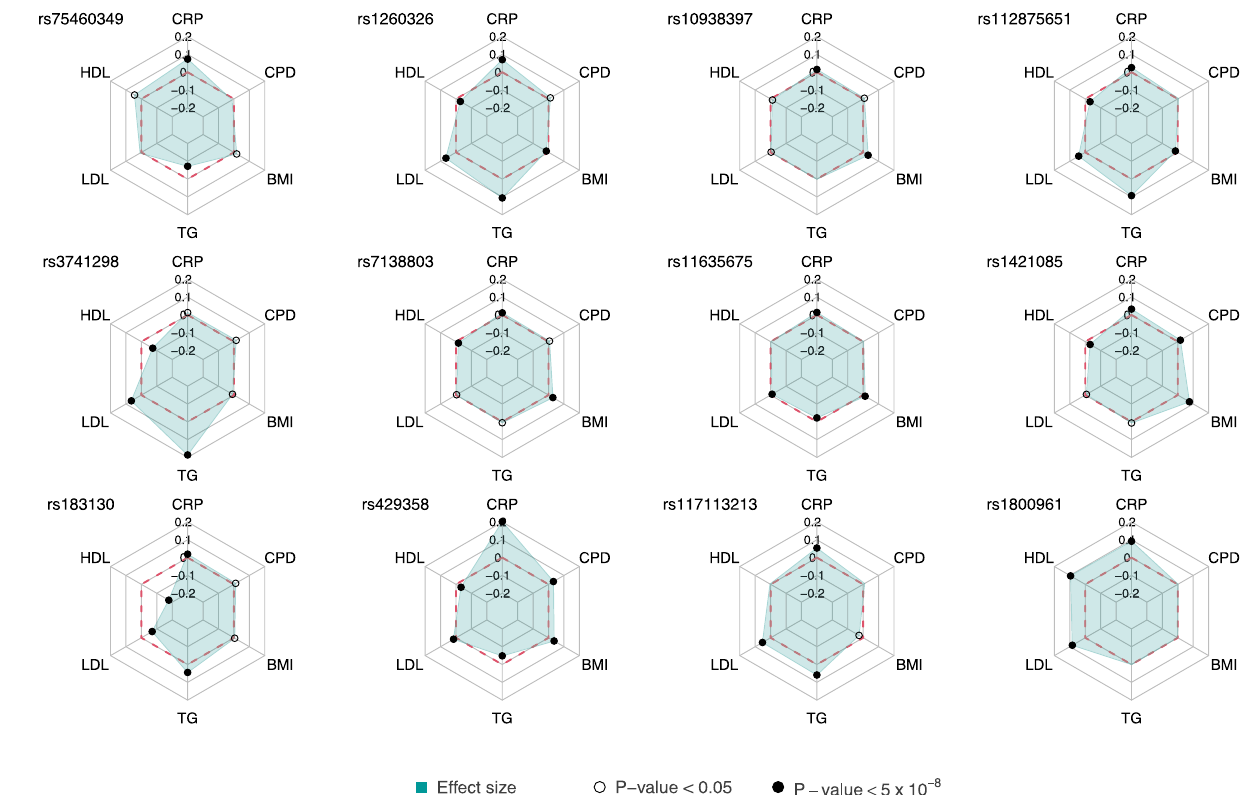
Fig. 3 | Effect size across traits for the 12 colocalized SNPs with a discordant direction of effect between C-reactive protein levels and any of the other examined traits. Inverse effect directions between CRP and any of LDL, TG, BMI, and CPD or direct directions between CRP and HDL were considered discordant if the association of the SNP with the discordant trait was statistically signi fi cant ( P <0.05)in multi-trait MTAG. Thered dashed line represents the zerovalue of the